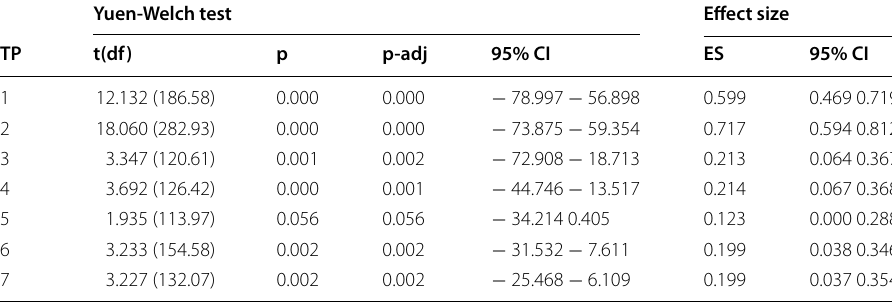
Table 4 Comparison of experimental conditions (control, non-gamified; and experimental; gamified) in terms of participants’ IDE usage in each time-point (TP)